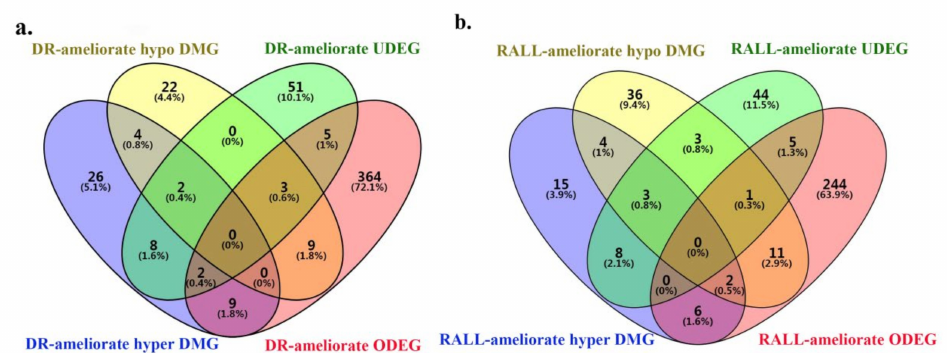
Figure 6. GO terms of biological processes enriched by four different gene sets of DR and RALL. ( a ) Overlapping GO terms enriched by DR-ameliorated DMGs and DR-ameliorated DEGs; ( b ) over- lapping GO terms enriched by RALL-ameliorated DMGs and RALL-ameliorated DEGs. GO terms significantly enriched by genes were defined as p -value < 0.01. We filtered out the GO terms that were in the top three locus levels of the biological process GO